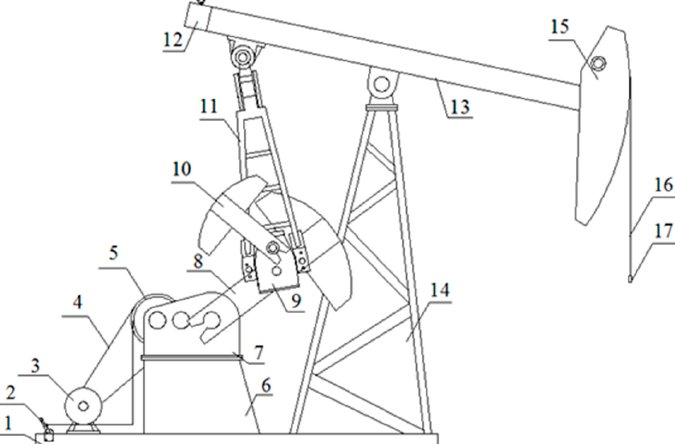
Figure 1. Structure diagram of positive torque beam pumping unit. 1—substructure; 2—manual